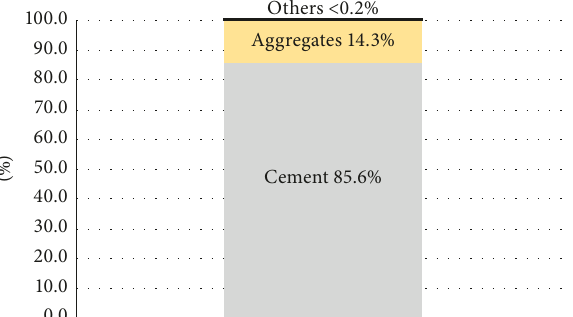
Figure 3: CO 2 - e by material type.